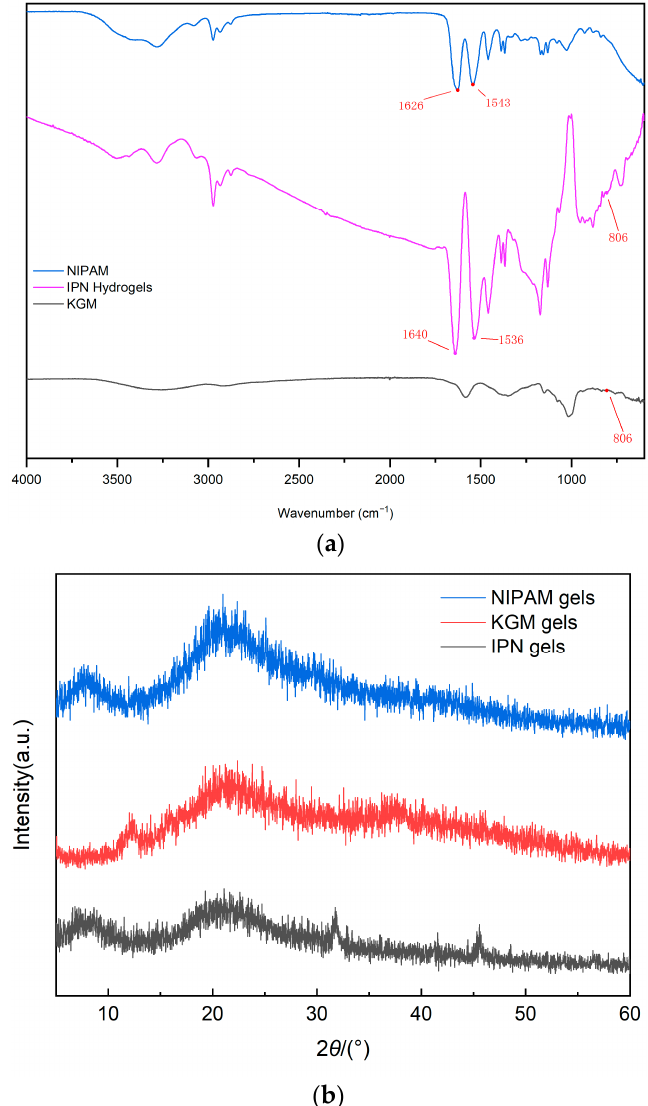
Figure 3. ( a ) The FT-IR spectra of KGM gel, NIPAM gel and IPN gel; ( b ) The XRD spectra of KGM gel, NIPAM gel and IPN gel.